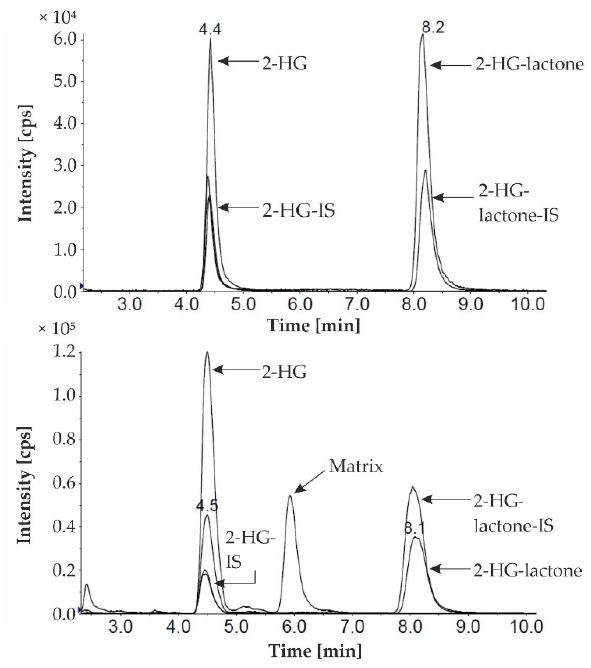
Figure 2. Chiral GC–MS analysis. The red trace shows the extracted ion chromatogram for the D- and L-enantiomer of the 2-HG derivative. The corresponding stable isotope-labeled internal standard (IS) is shown in green. The extracted ion chromatogram for the D- and L-enantiomer of the 2-HG-lactone derivative is shown in black, and the corresponding IS-trace in purple. The upper panel shows a racemic D/L-2-HG standard, and the lower panel shows a serum sample of an acute myeloid leukemia (AML) patient with an IDH2-R140Q mutation. For standard solutions, the ratio of each enantiomer of 2-HG and -lactone was found to be consistent. For the serum sample, both L-enantiomers were hardly detectable, while the ratio of D-lactone/2-HG was found to be increased for the unlabeled analyte.